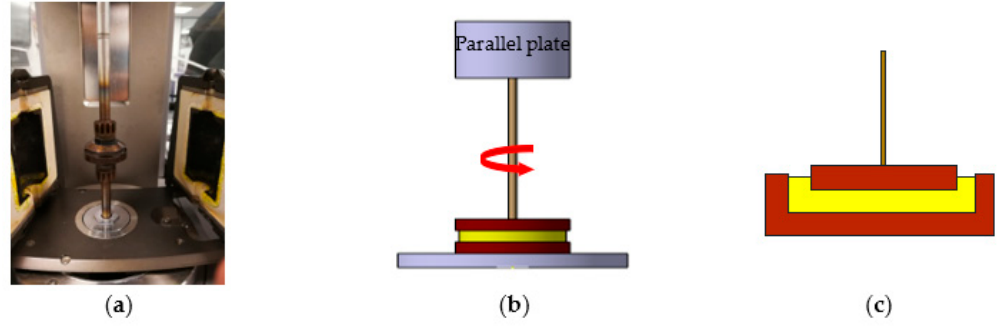
Figure 2. Rheometer used in the measurement. ( a ) MCR 502, ( b ) geometry of the rheometer, parallel plate, ( c ) schematic of loaded sample.